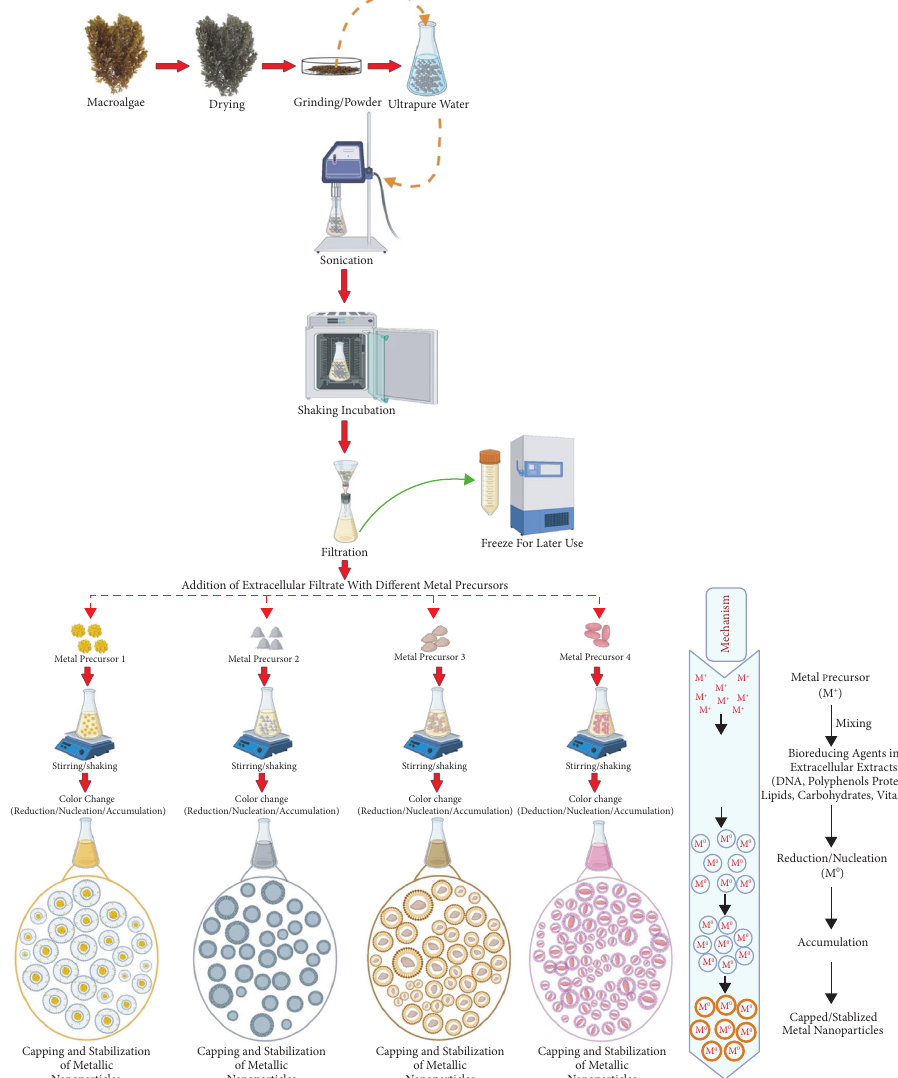
Figure 6: Illustration exhibiting green synthesis of NPs using extracellular extract of macroalgae without heating. Created with BioRender. com with publication